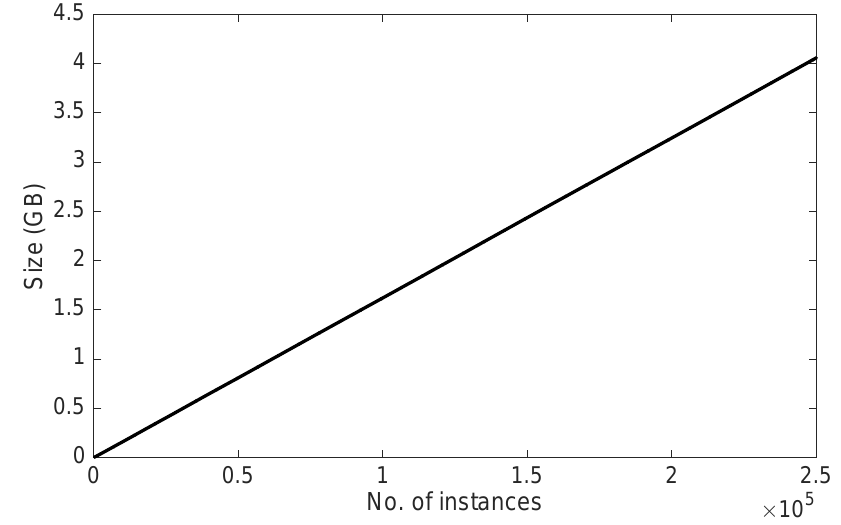
Figure 10. Size of the Context Storage depending on the number of persisted instances of high-level context. It must be noted that the storage of each high-level context instance has associated the storage of the low-level context instance which triggered its creation. Thus, for example, 250,000 instances in the X-axis represent 250,000 high-level contexts plus 250,000 low-level contexts stored on